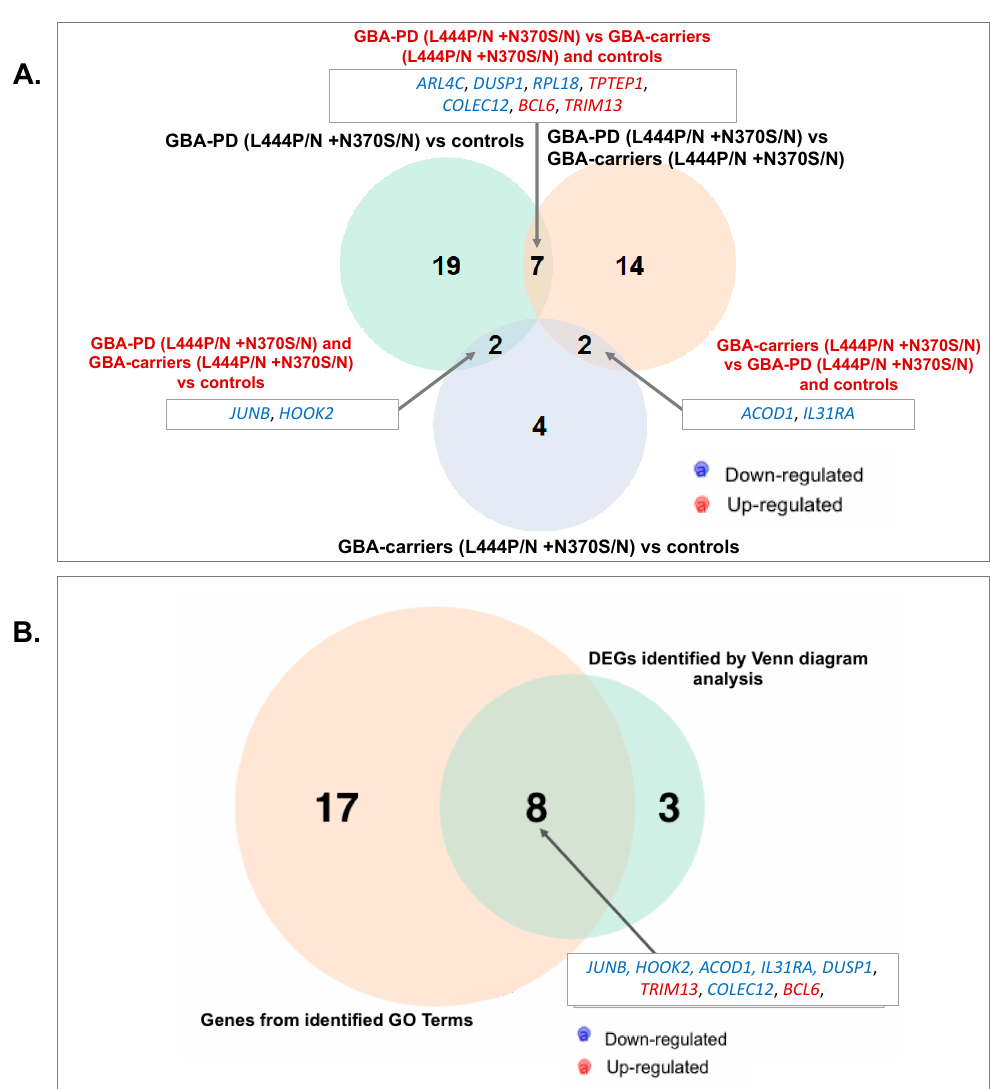
Figure 6. Venn diagram of ( A ). DEGs in monocyte-derived macrophages of GBA-PD (L444P/N +N370S/N) patients to controls compared to GBA-PD (L444P/N +N370S/N) patients to GBA carriers (L444P/N +N370S/N), and compared to GBA carriers (L444P/N +N370S/N) and controls; B. DEGs determined be Venn diagram in ( B ) and DEGs determined by GO analysis for GBA-PD (L444P/N +N370S/N) patients, GBA carriers (L444P/N +N370S/N), controls. All data are presented as the number of genes with a p -value < 0.05 and |FC| more than 1.5. Three Venn diagrams were developed using the library VennDiagram (v.1.6.20) in R (v.4.0.3). (GBA-PD—Parkinson’s disease associated with mutations in the GBA gene; GBA